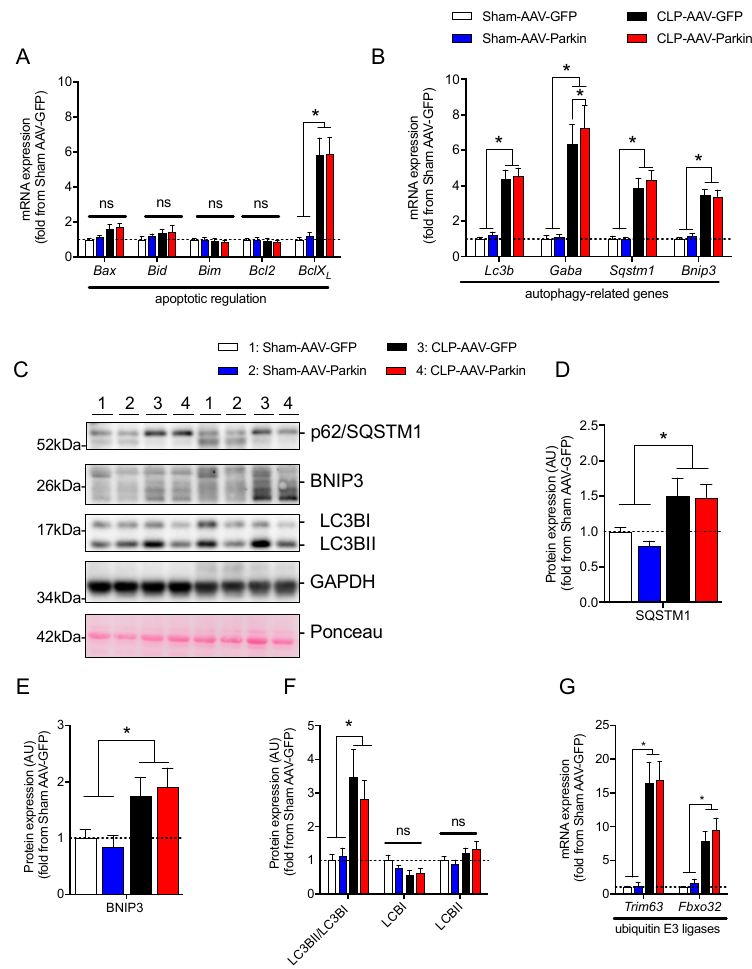
Figure 3. The impact of Parkin overexpression and sepsis on skeletal muscle catabolic signaling. ( A ) qPCR analysis of the mRNA expression of genes regulating apoptosis in the gastrocnemius (GAS) muscles of Sham and CLP animals injected with either AAV-GFP or AAV-Parkin. ( B ) qPCR analysis of autophagy-related gene expression in the gastrocnemius (GAS) muscles of Sham and CLP animals injected with either AAV-GFP or AAV-Parkin. Gaba. refers to Gabarapl1 . ( C ) Immunoblot detectionofSQSMT1(p62), BNIP3, LC3I / LC3IIandGAPDH.( D )QuantificationofSQSMT1(p62)content. ( E ) Quantification of BNIP3 protein content. ( F ) Quantification of LC3I and LC3II protein content, as well as the LC3II to LC3I ratio. ( G ) qPCR analysis of Fbxo32 (Atrogin-1) and Trim63 (MuRF1) gene expression levels in the GAS muscles of Sham and CLP animals injected with either AAV-GFP or AAV-Parkin. 1 = Sham-AAV-GFP; 2 = Sham-AAV-Parkin; 3 = CLP-AAV-GFP; 4 = CLP-AAV-Parkin. Data are presented as mean ± SEM. ( n = 6–9 / group, * = statistically significant; ns = not statistically